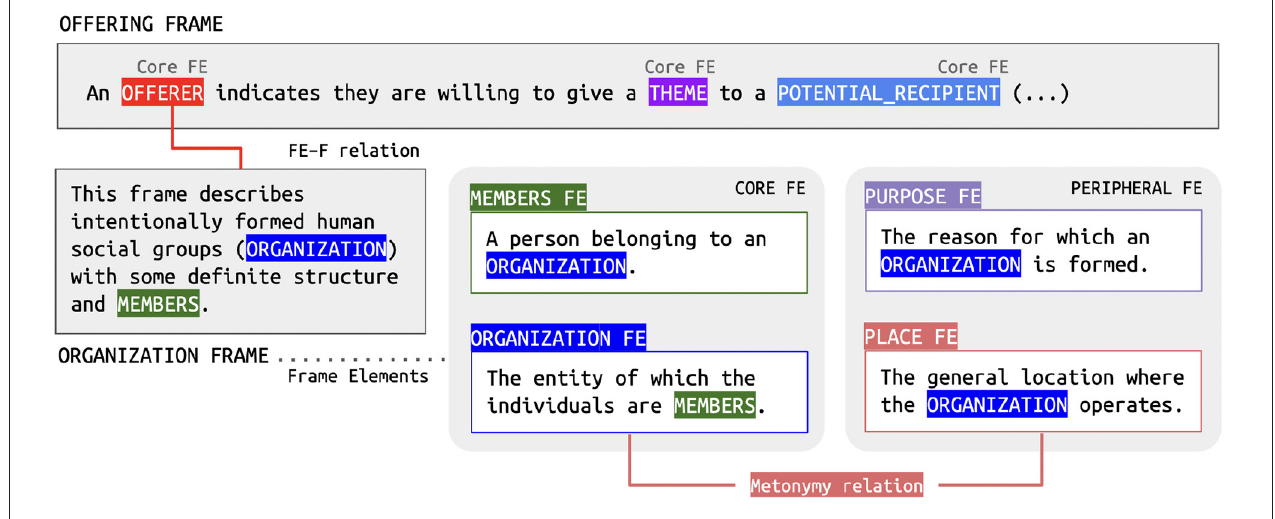
FIGURE 4 | An instance of the Metonymy relation in the FN-Br